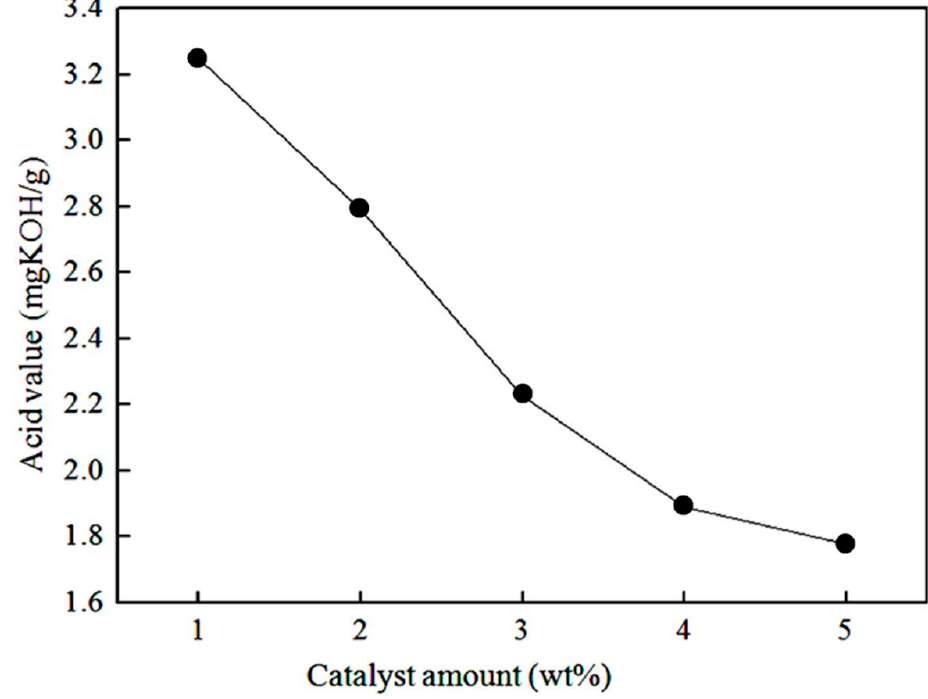
Figure 4. Effect of catalyst amount on the acid value.